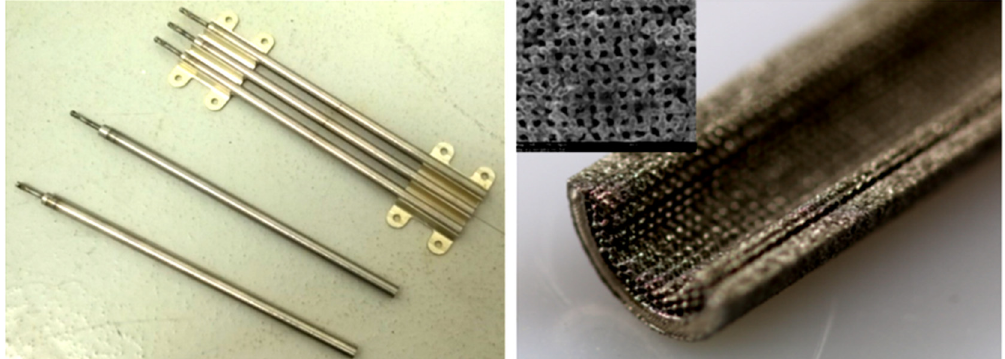
Figure 13. Titanium AM HP ( left ) and HP assembly ( right ) [17].